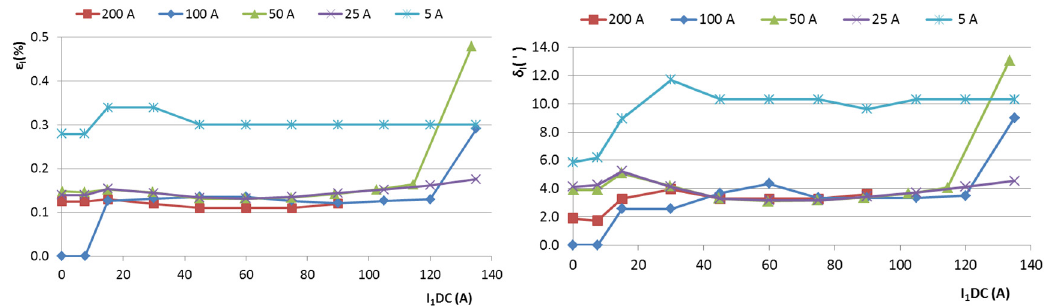
Figure 9. Amplitude and phase errors of the DC-compensated current transformer as a function of the primary DC current.